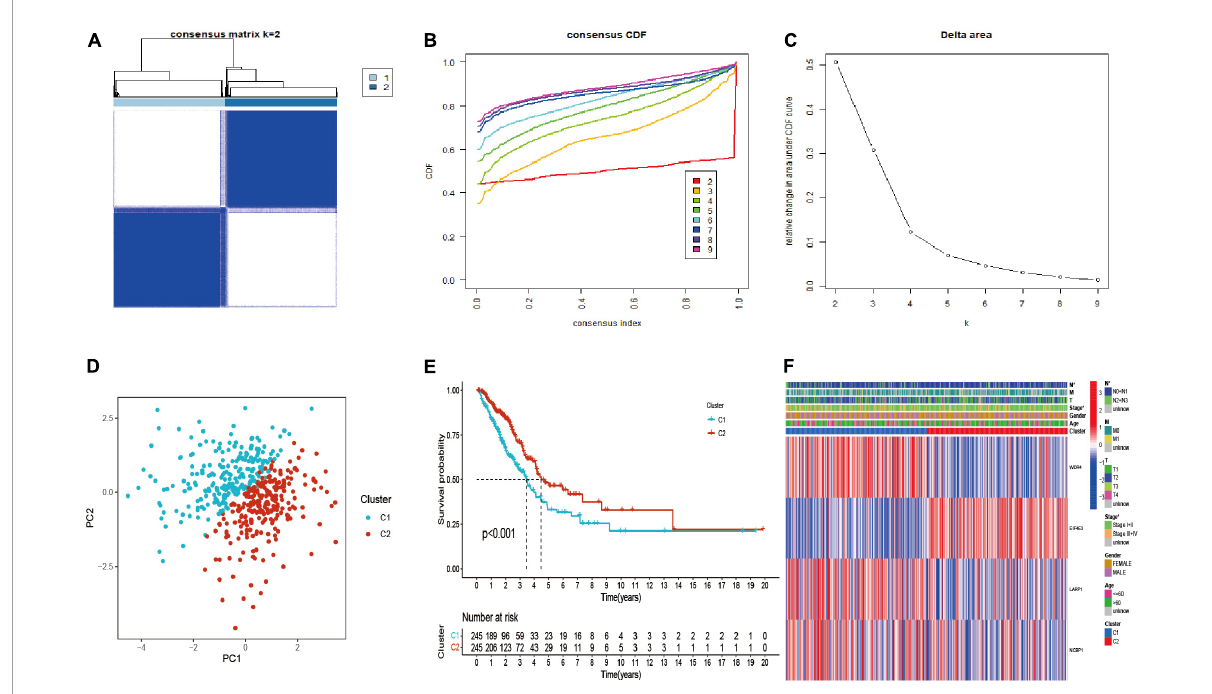
FIGURE3 Identification, survival, and clinical characteristics analysis of molecular subtype. (A–C) The optimal value of consensus clustering. (D) Distribution of all patients. (E) Survival analysis in C1 and C2 subtypes. (F) Heatmap of prognostic gene and clinicopathological features between two subtypes. * P <